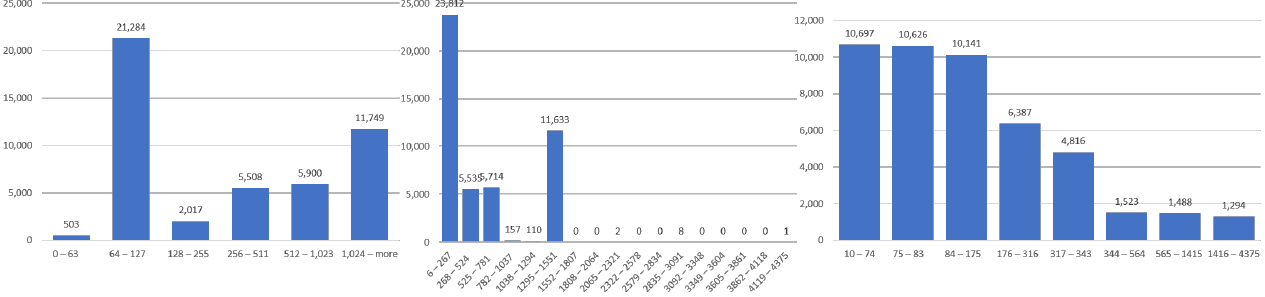
Figure 5. The histogram of one-payload length with BW ( left ), SEW ( center ), and SEF ( right ). The x-axis is the bin range, while y-axis is the member count.